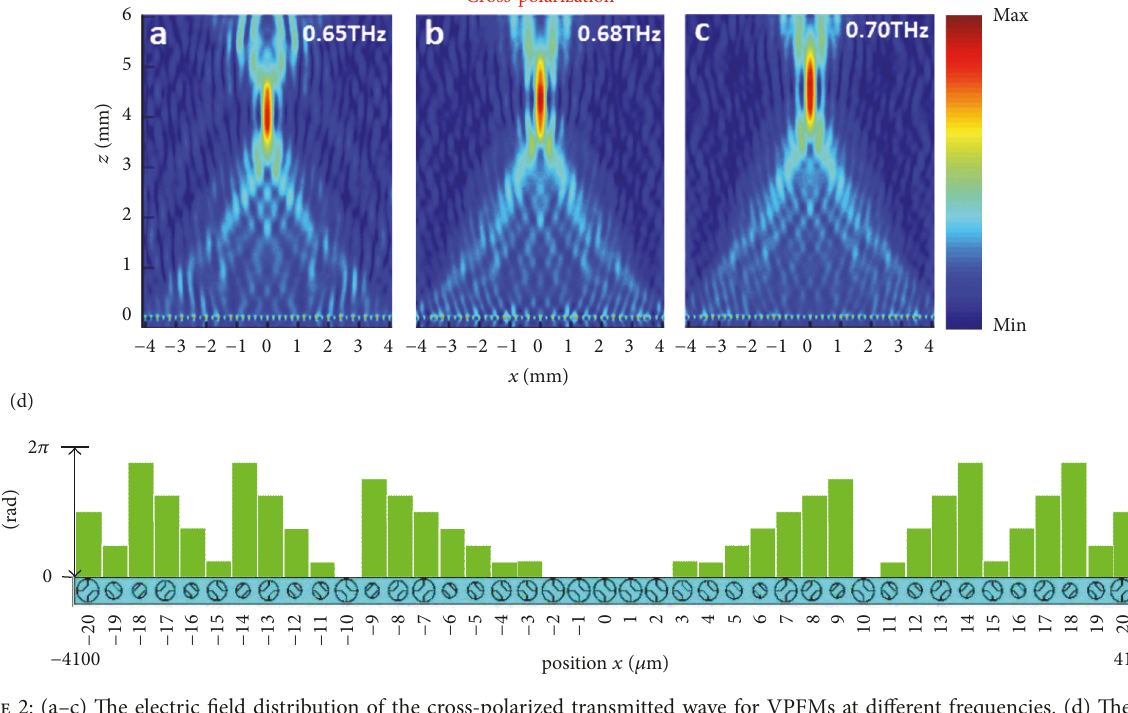
Figure 2: (a–c) The electric field distribution of the cross-polarized transmitted wave for VPFMs at different frequencies. (d) The phase distribution of VPFMs composed of 41